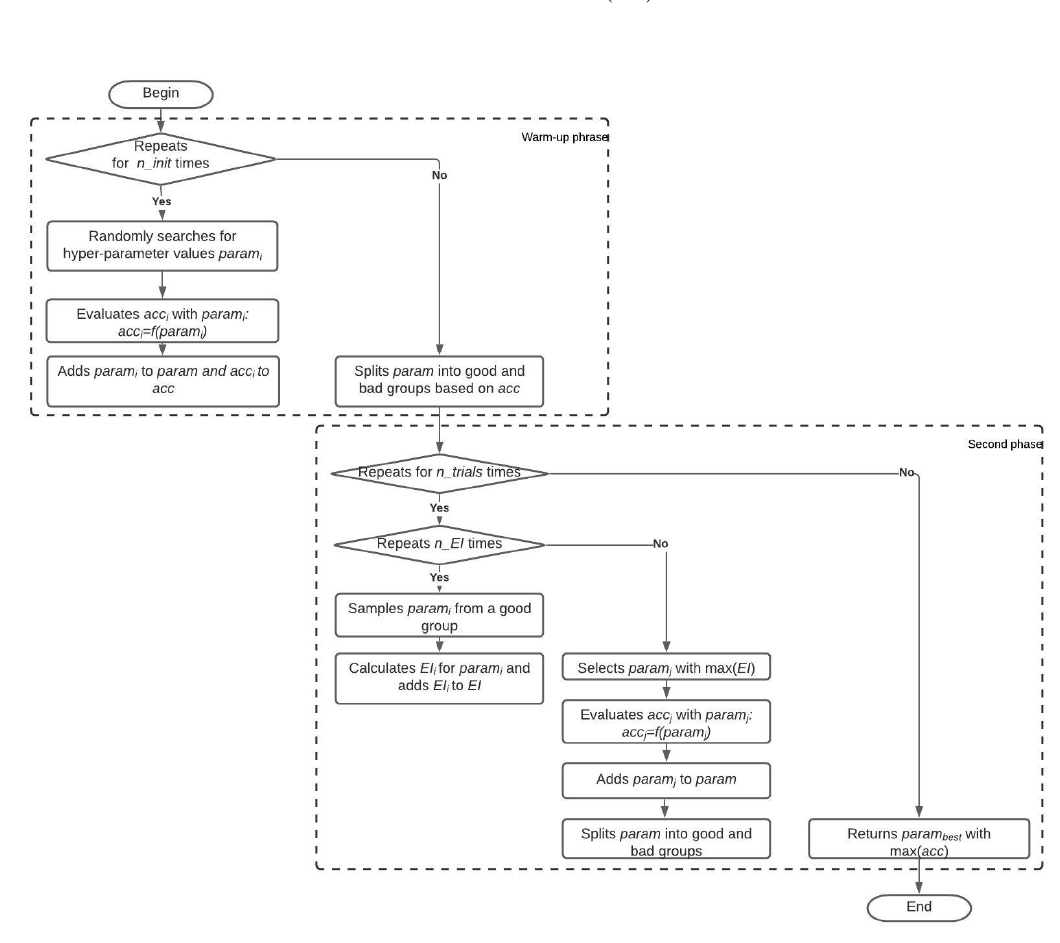
Figure 1. A schematic representation of the TPE (tree-structured Parzen estimator) optimization algorithm.